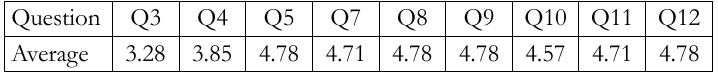
Table 1. Average of the questions in the survey that have a Likert